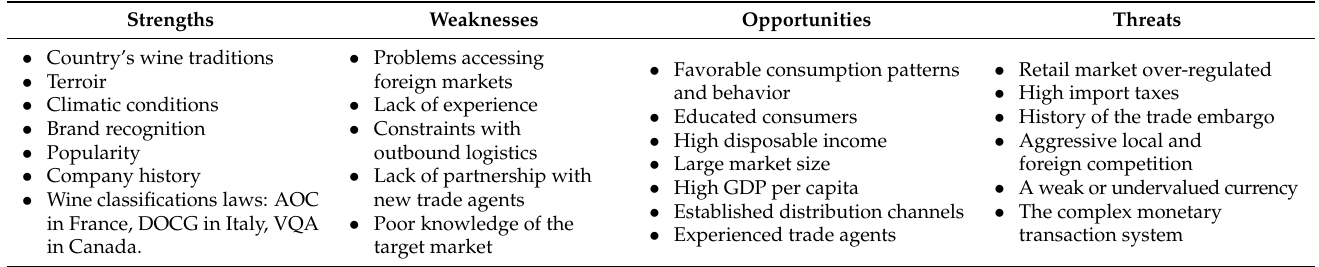
Table 8. Sample SWOT analysis for a wine company.